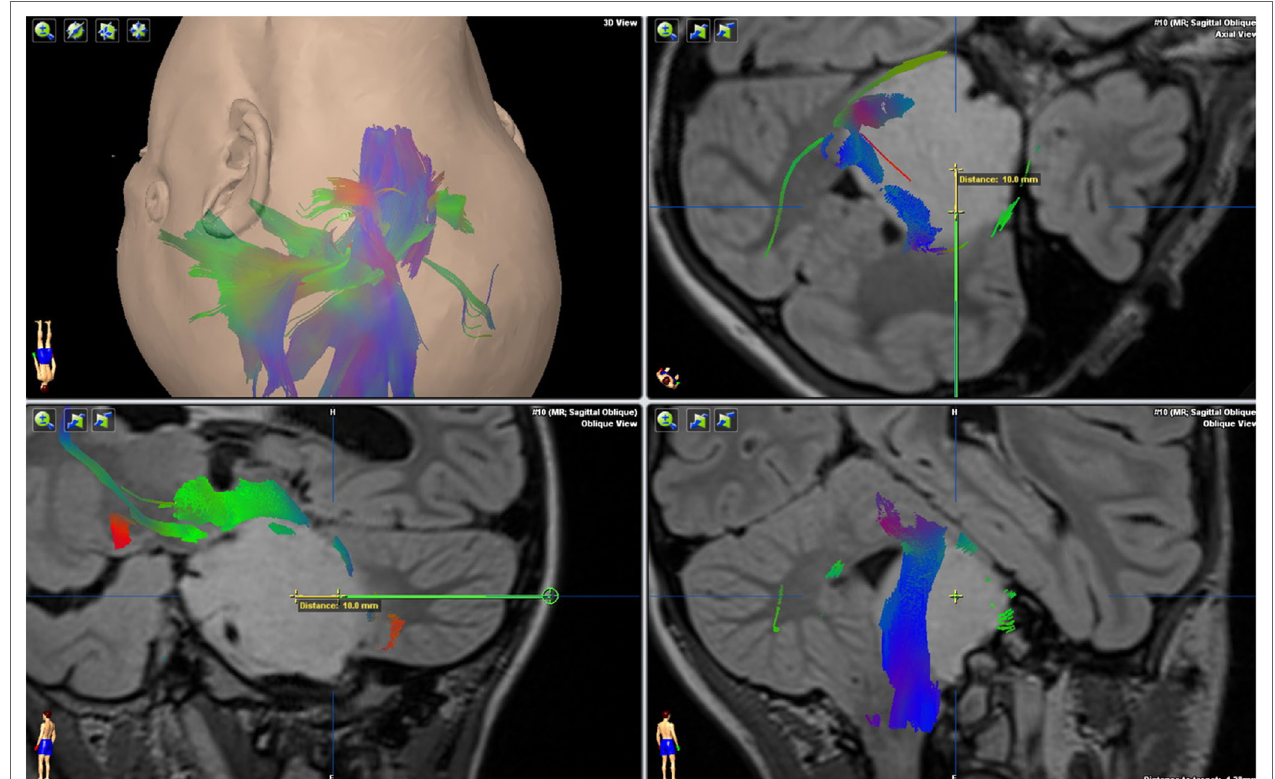
FIGURe 1 | Magnetic resonance imaging T2 FLAIR 3D sequence, with DTI tractography fusion showing the relationship between the tumor and major brain tracts. The green trajectory of the biopsy avoids the corticospinal tract ending in the biopsy target. The yellow segment notes the extra depth (10 mm) of the infusion cannula